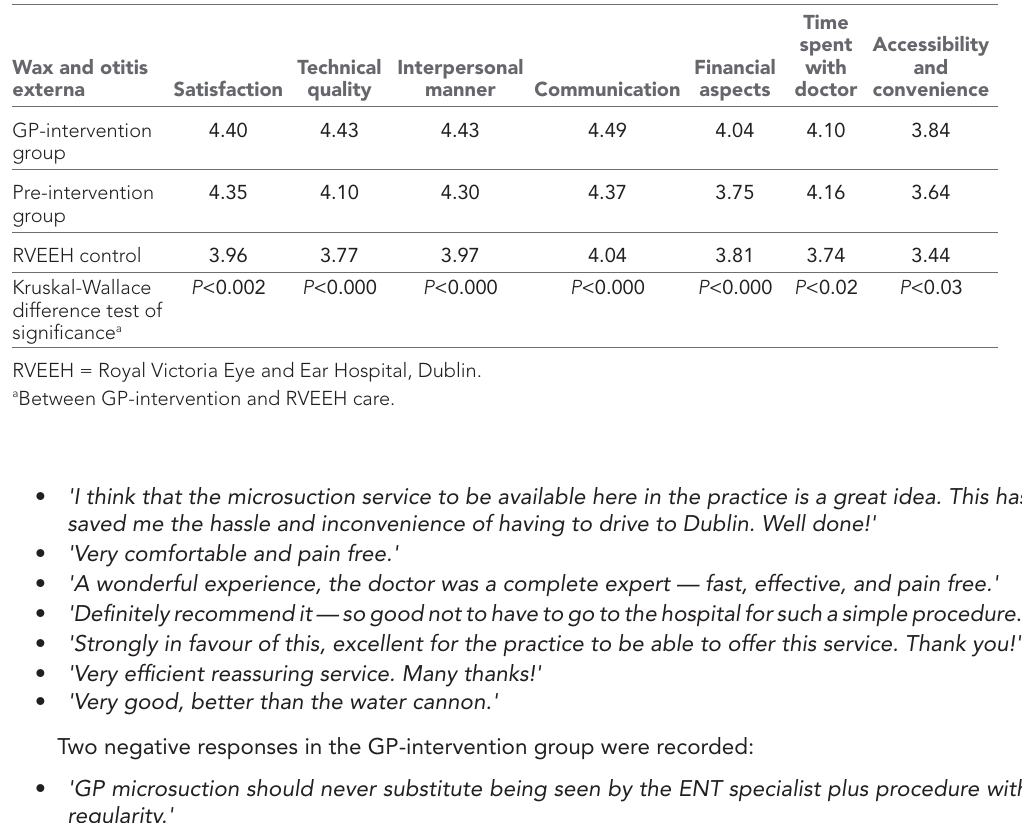
Table 1 Average (mean) Likert scales in each of seven areas for the three groups, and Kruskal-Wal- lace test of